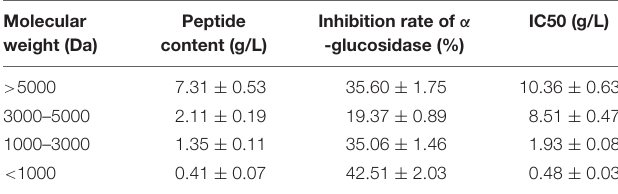
TABLE 1 | Results of fractional enrichment of MBPs.